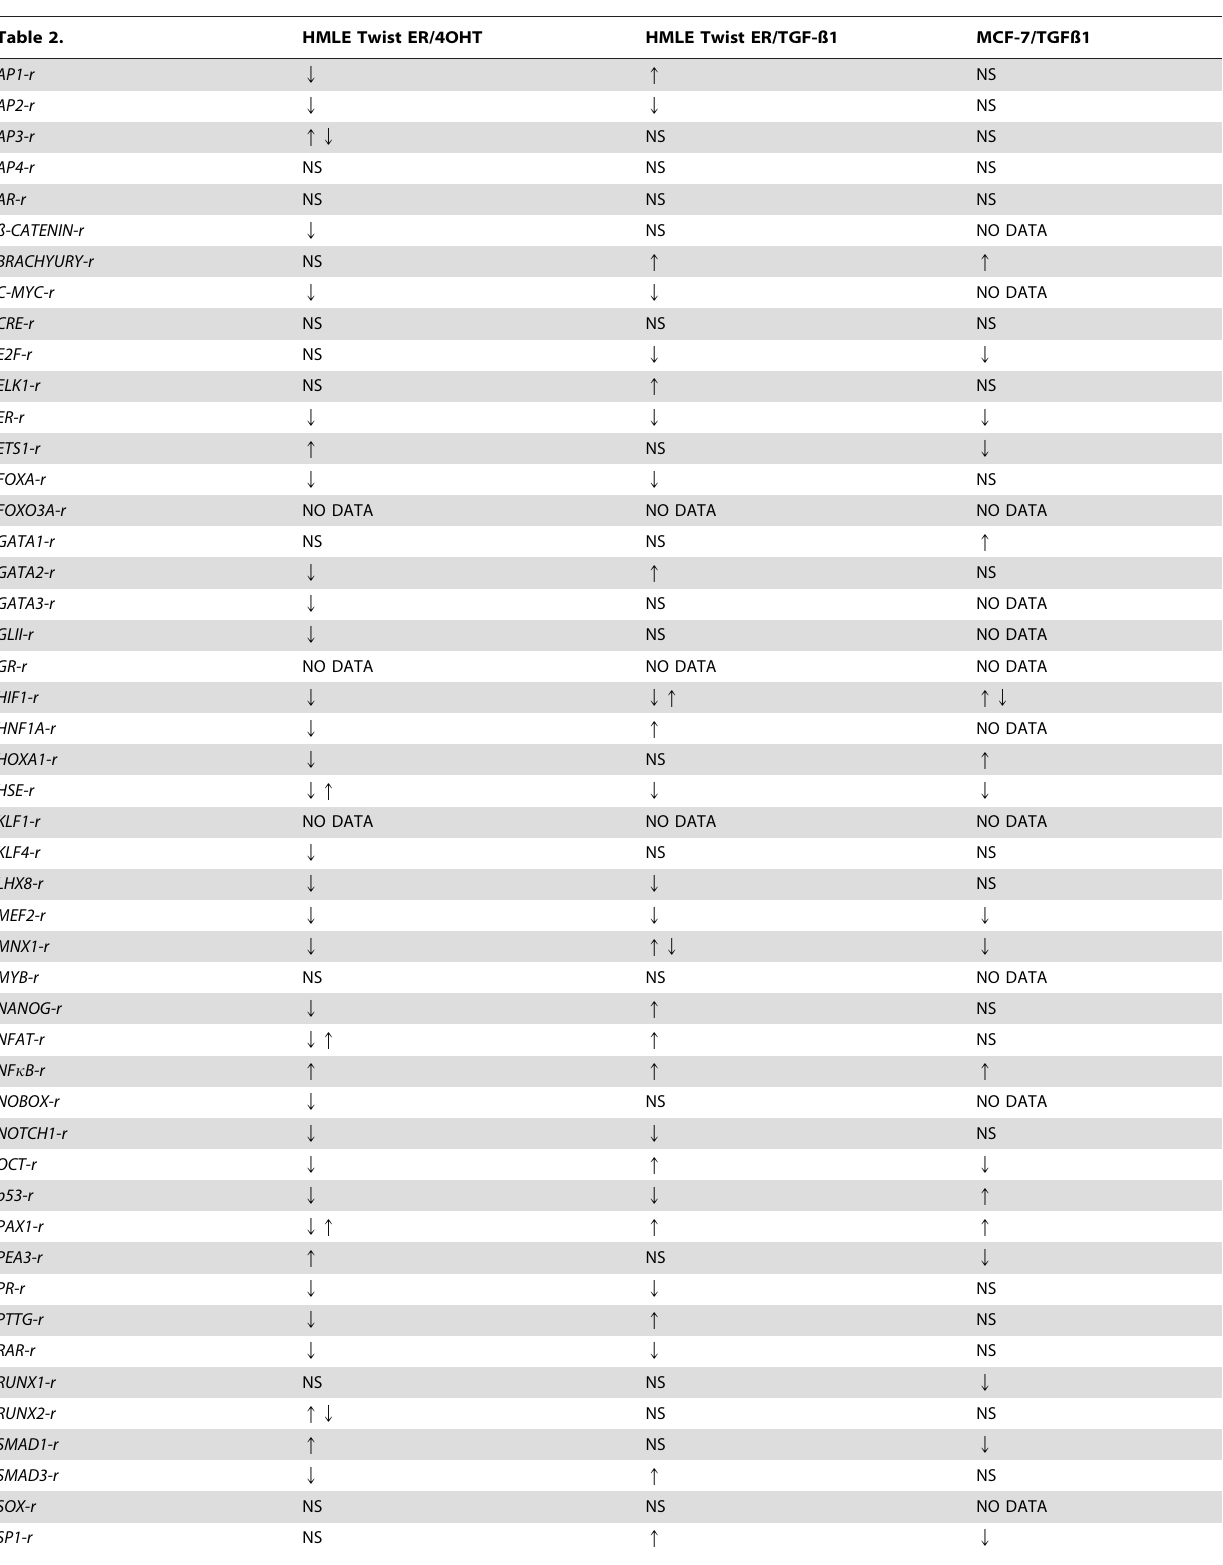
Table 2. Summary of significant differences in TF reporter activation relative to vehicle controls during 6 days of EMT induction in three models.